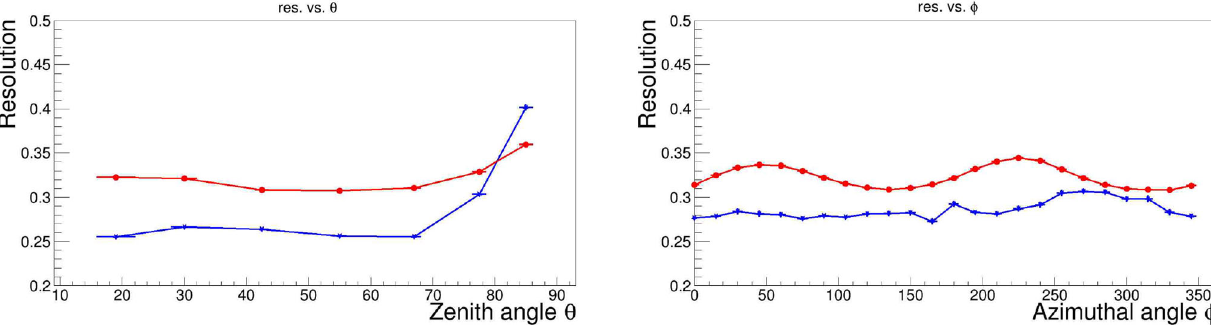
Fig. 36 Uniformity of the SPE charge resolution along the zenith angle ( θ , left) and azimuthal angle ( φ , right). HPK: blue; NNVT: red